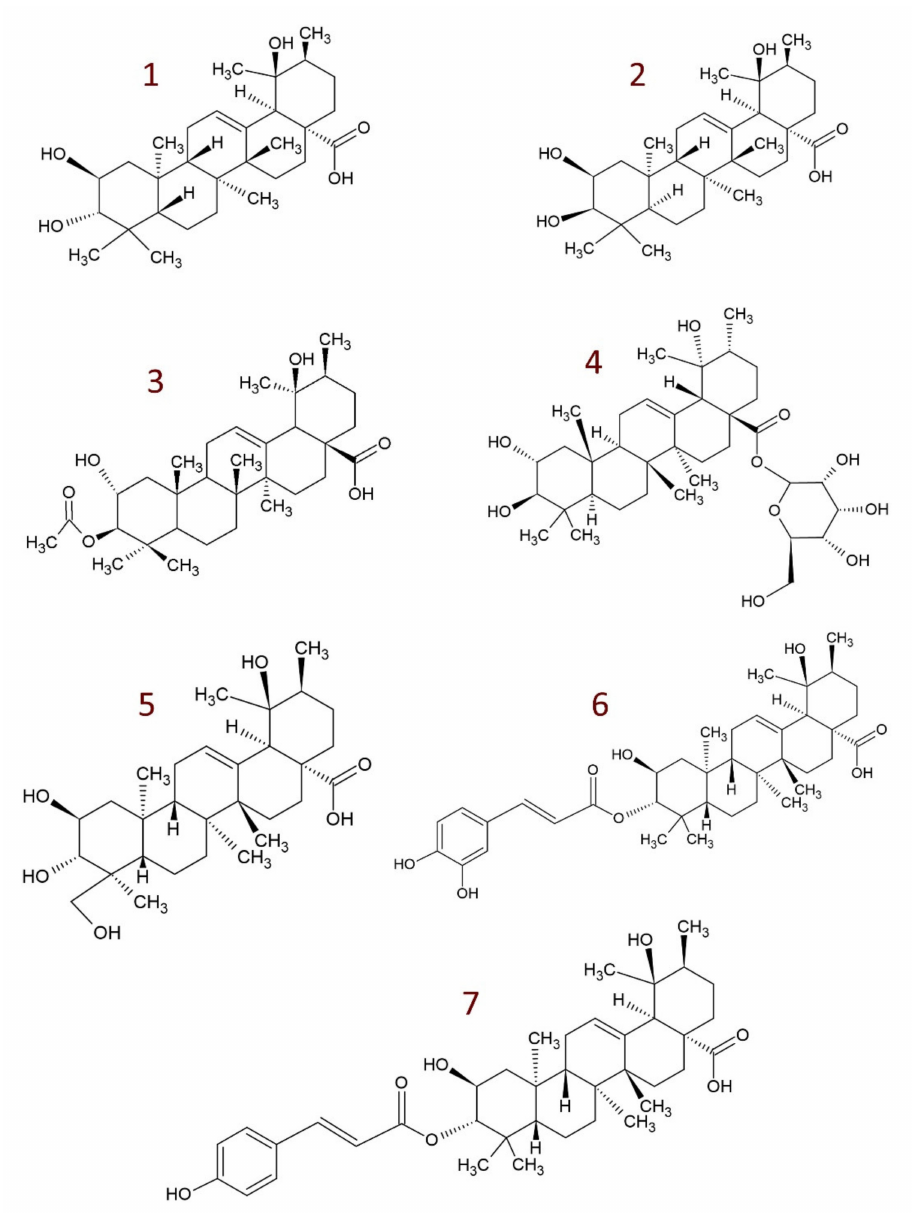
Figure 1. Structure of tormentic acid ( 1 ) and its common natural derivatives; 2 —euscaphic acid; 3 —3 β -acetyl tormentic acid; 4 —rosamultin; 5 —23-hydroxytormentic acid; 6 —3- O - trans - caffeoyltormentic acid; 7 —3- O - cis - p -coumaroyltormentic